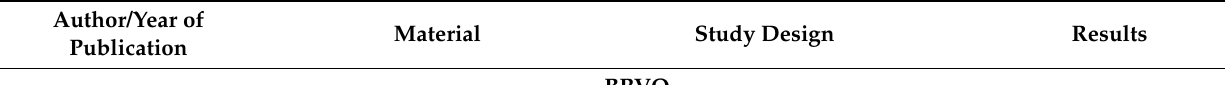
Table 2. Studies that assessed the combination of SDM and intravitreal treatment without results for intravitreal ther- apy